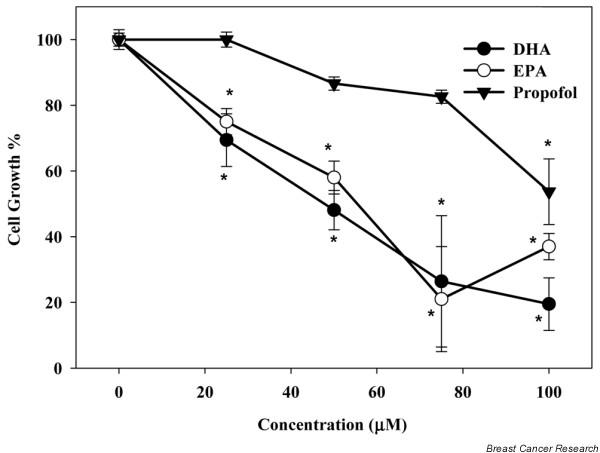
Effect of docosahexaenoic acid (DHA), eicosapentaenoic acid (EPA) and propofol on cellular growth. Cells (104 per well) were seeded overnight in a 96-well plate and then treated for 24 hours with various concentrations of DHA, EPA or propofol in serum-free medium. Cell growth was assayed with a WST-1 assay as described in the Materials and methods section. Results are means ± SEM for three experiments. The results were analyzed by analysis of variance and Dunnett's multiple comparison test to control the Type I experimental wise error. Significant differences from the control (P < 0.05) are indicated with an asterisk.